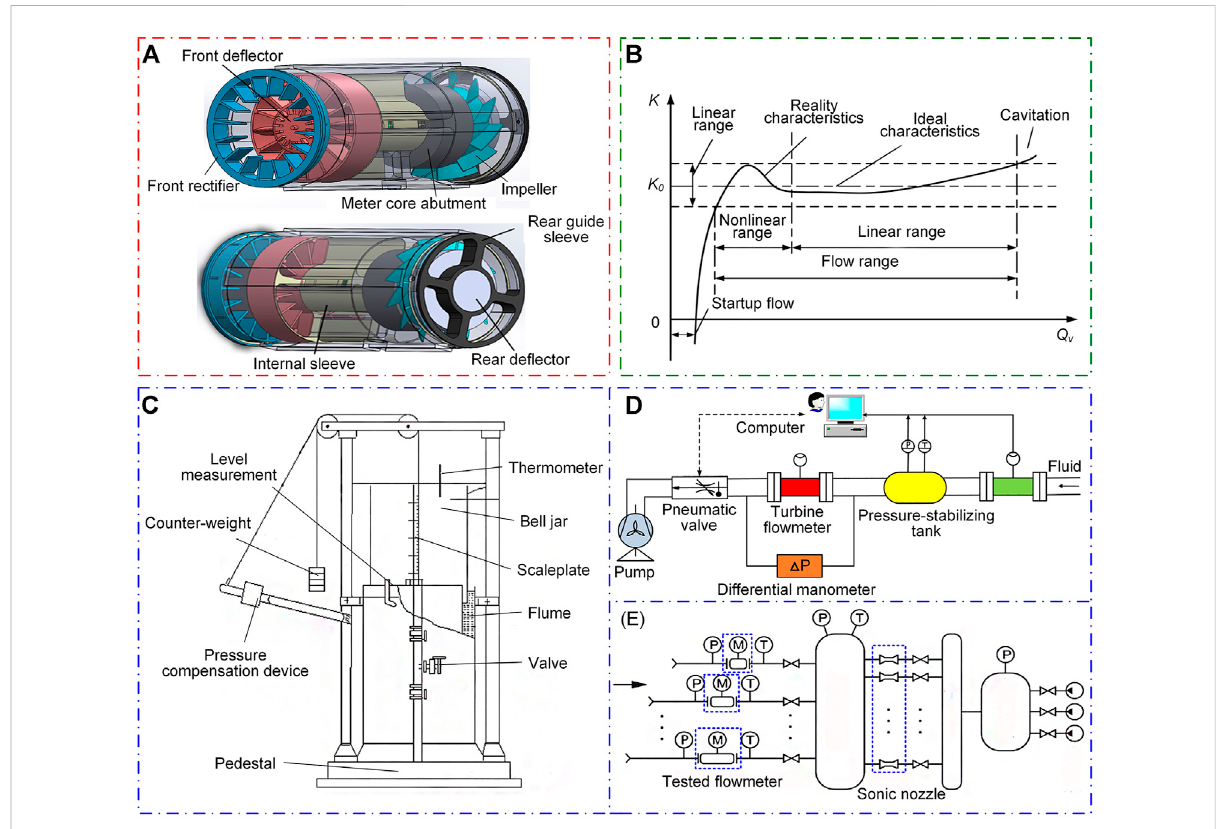
FIGURE 1 Flowratemeasurementofgasturbine fl owmeter: (A) Physicalmodelofagasturbine fl owmeter, (B) K-Qcurveofthegasturbine fl owmeter, (C) bell jar – type gas fl ow standard device, (D) standard meter method fl ow standard device, and (E) sonic nozzle method gas fl ow standard